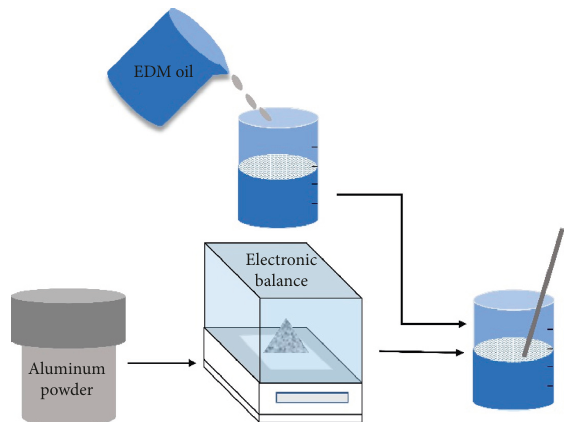
Figure 3: Preparation of different EDM oil with Al